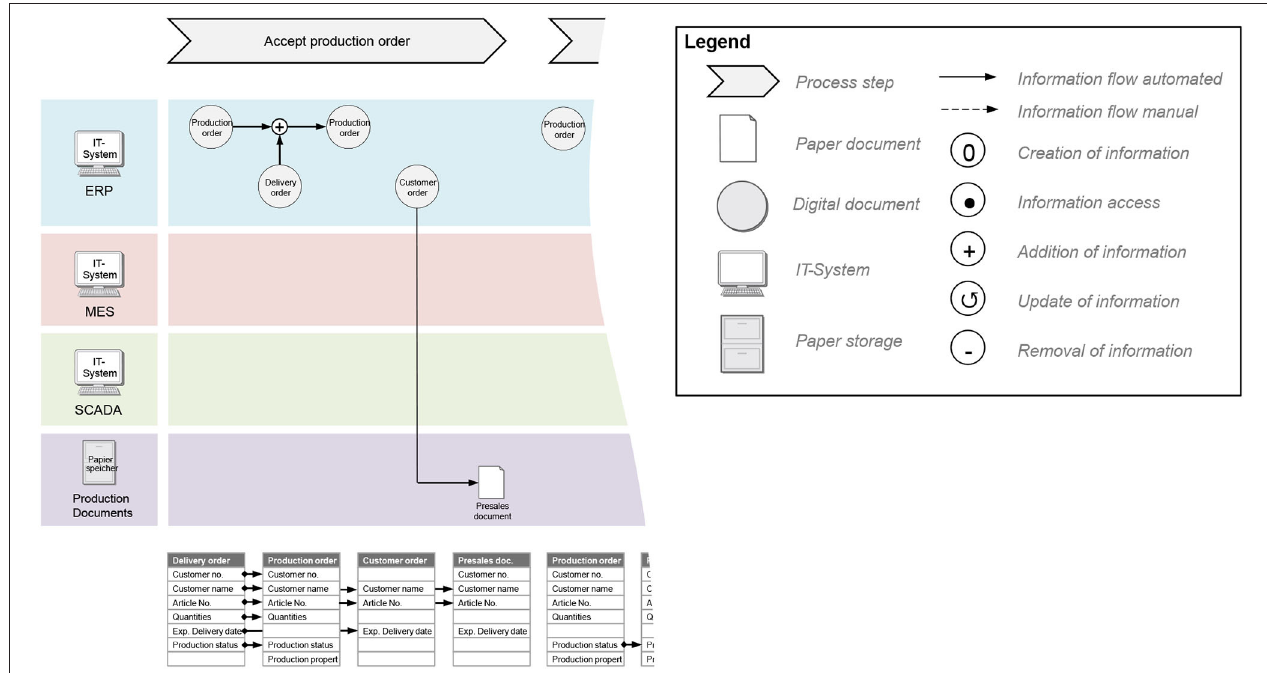
FIGURE 8 | Data Map for the visualization of data sources and data flow along the manufacturing